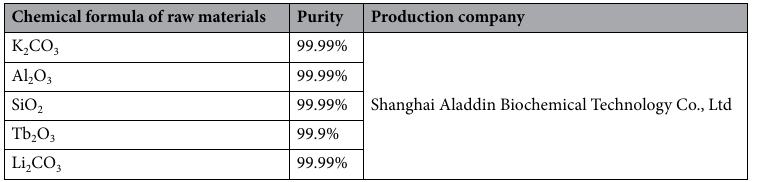
Table 2. Raw materials of KAlSiO 4 : Tb 3+ , Li + phosphor.